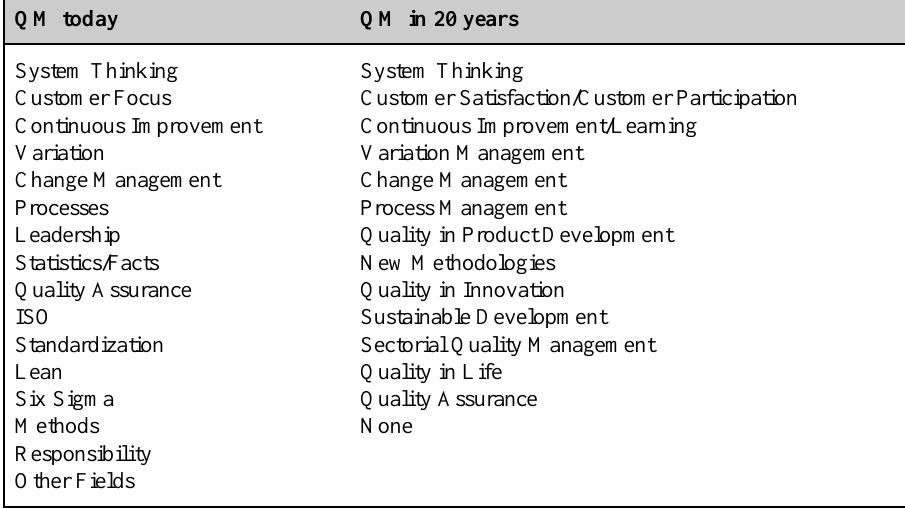
Table 1– Notes clusters from the workshop at Chalmers University of Technology QM today